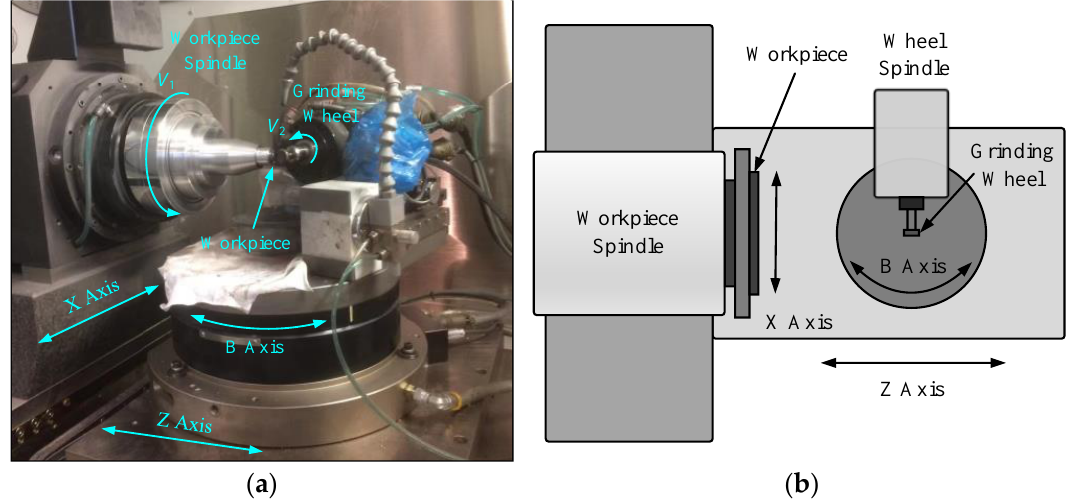
Figure 4. Configurations of 4-axis ultra-precision grinding machine: ( a ) ultra-precision machine tool for grinding experiments; ( b ) structural layout of the grinding machine.